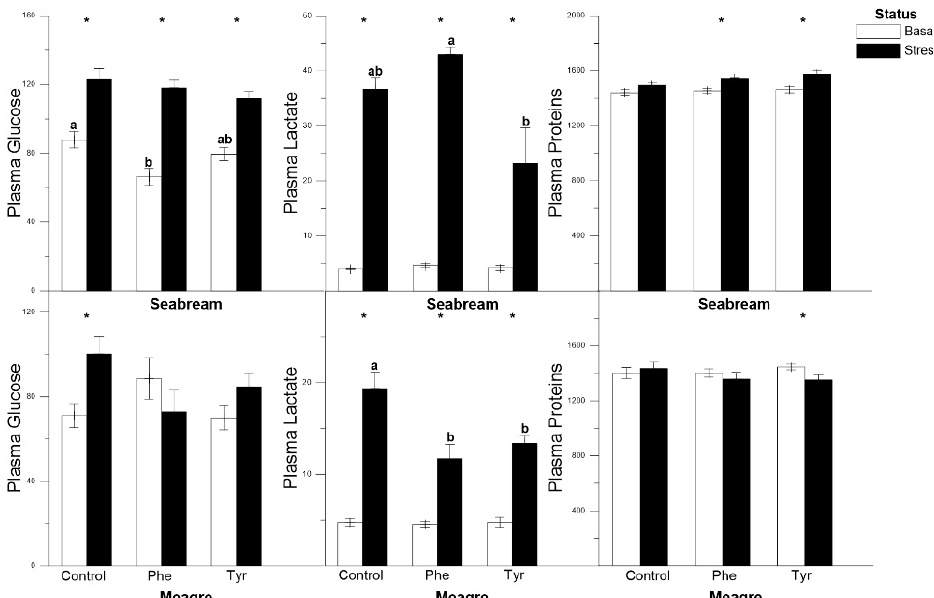
Figure 1. Plasma glucose, lactate and proteins concentrations (mg dL − 1 ) for each treatment (mean ± SE, n = 10). The white and black bars are the basal and stress values, respectively. Asterisks indicate significant differences between the basal and stress conditions. Different letters indicate significant differences among feeding treatments within every condition.